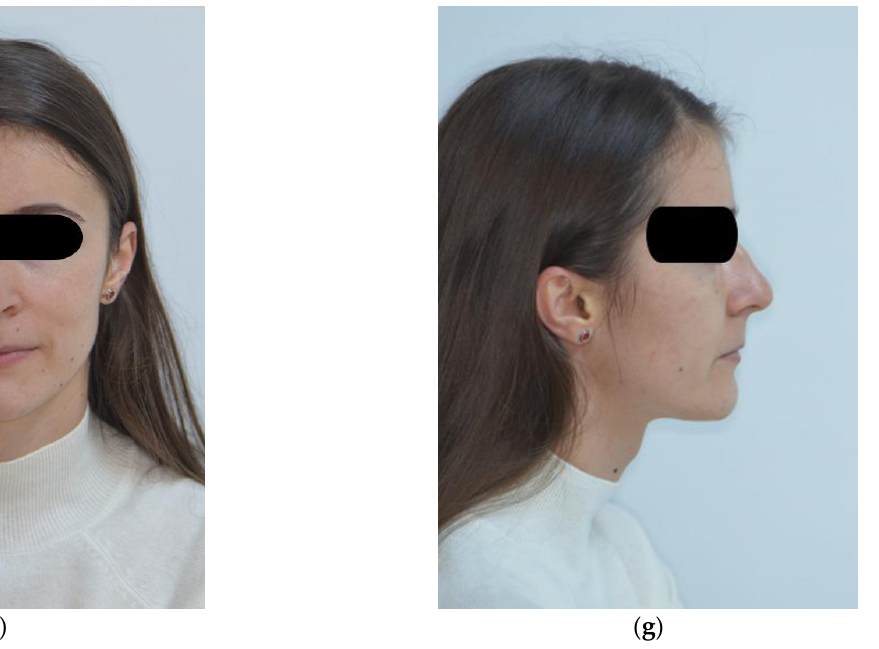
Figure 2. Initial situation ( a ) Right lateral occlusal view; ( b ) Left lateral occlusal view; Initial situation ( c ) Frontal occlusal view; Initial situation ( d ) Upper arch; ( e ) Lower arch; Initial situation, extraoral photos ( f ) Frontal view; ( g ) Lateral view. Table 3. Lateral cephalometric measurements.